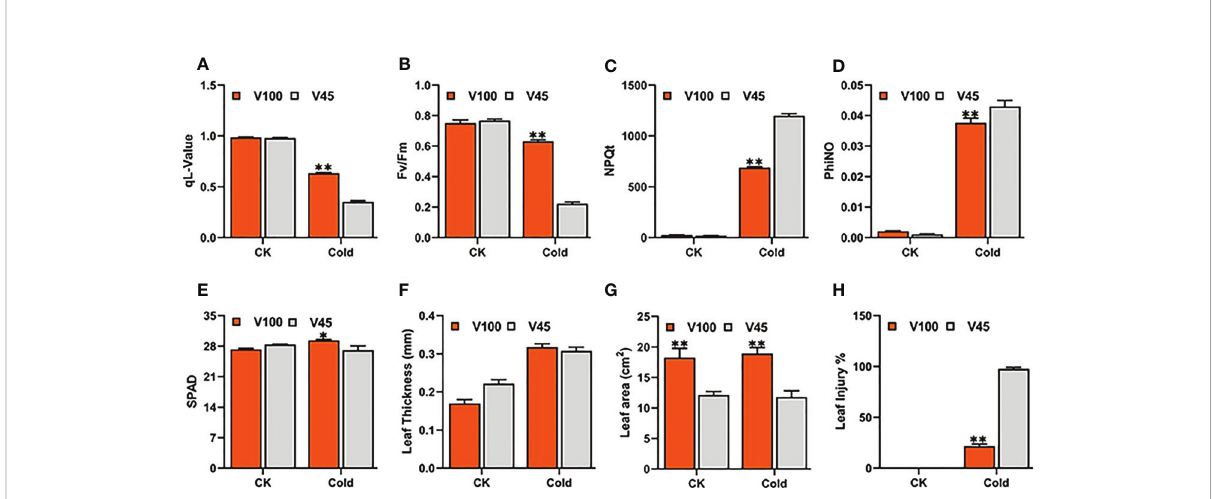
FIGURE 4 Physiological and phenological differences between V100 and V45. Traits were recorded under control 22°C and cold stress 4°C conditions. (A) qL-value, (B) Fv/Fm, (C) NPQt, (D) phiNO, (E) SPAD, (F) Leaf thickness (LT), (G) Leaf area, (H) Leaf injury (LI). Data was analyzed with the Statistix 8.1. The ** and * asterisks indicate the signi fi cant differences at p-value <0.01 and p-value <0.05*,